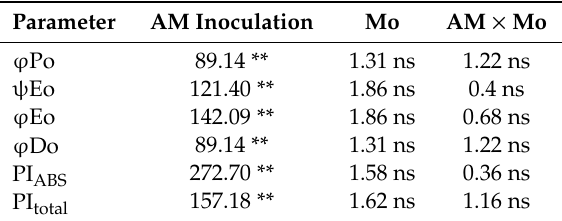
Table 3. Two-way ANOVA results from AM inoculation, Mo addition concentration and their interactions the JIP-test parameters.